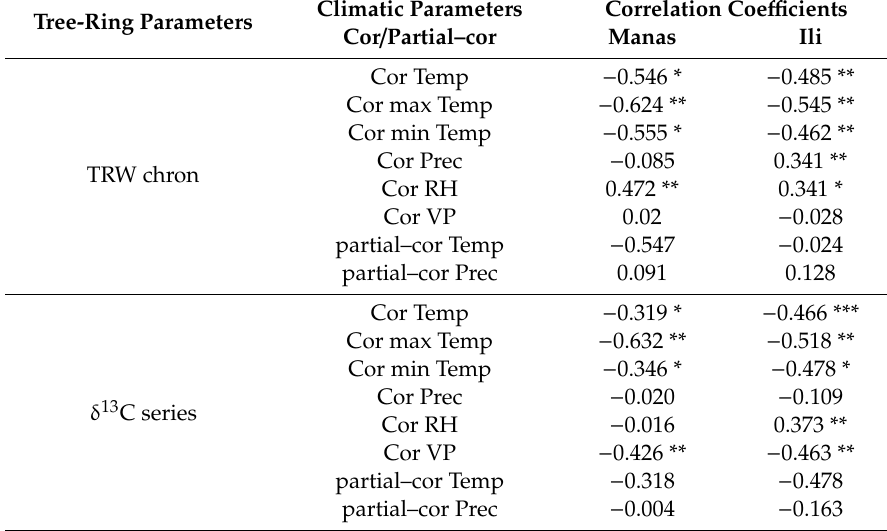
Table 7. Correlation analysis between the tree-ring variables (TRW chronologies and δ 13 C series), climatic factors of the Ili and Manas for the time period from the previous July to the September of the same